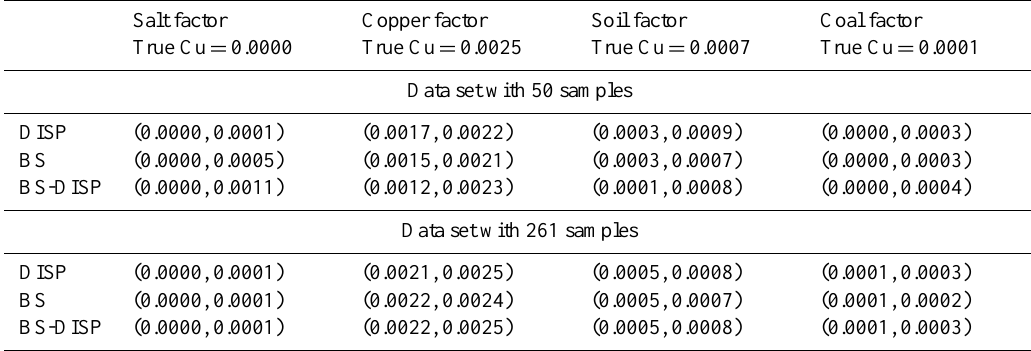
Table 2b. Lower and upper interval estimates of Cu (µgm − 3 ) by factor for Case 2 (realistic errors) for data sets with 50 or 261